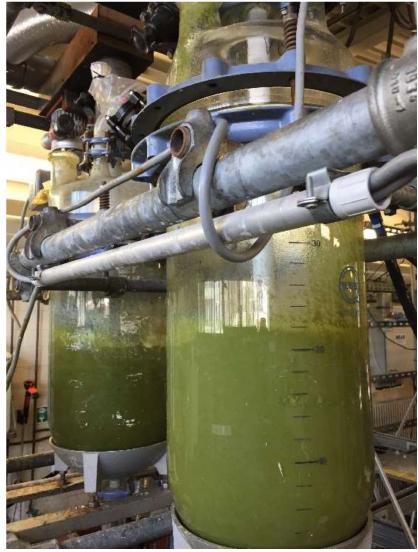
Figure 14. Treatment of eudialyte concentrate in two reactors at the Institute of Process Metallurgy and Metal Recycling (IME) demonstration plant, RWTH